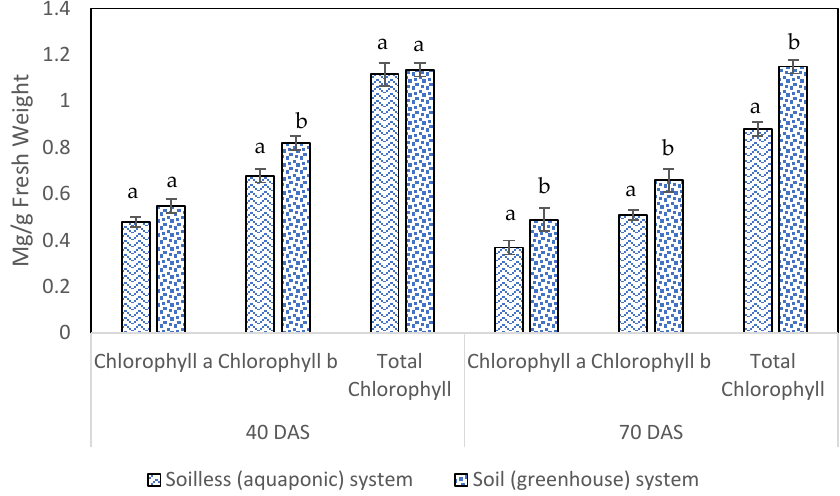
Figure 2. Chlorophyll contents of Ocimum basilicum in (aquaponic) and soil (greenhouse) systems at 40 and 70 DAS. Values are given as mean ± SD of seven samples in each group. Values that do not share a common superscript (a, b) differ significantly at p ≤ 0.05 using t -test.